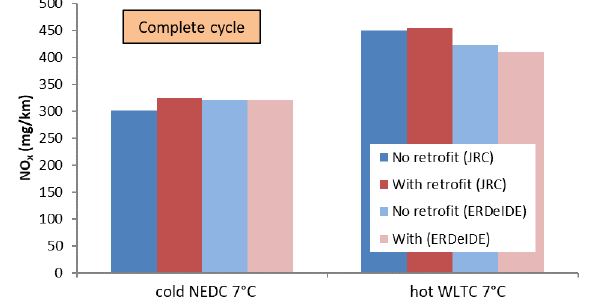
Fig. 3. NO x results for the complete cycles